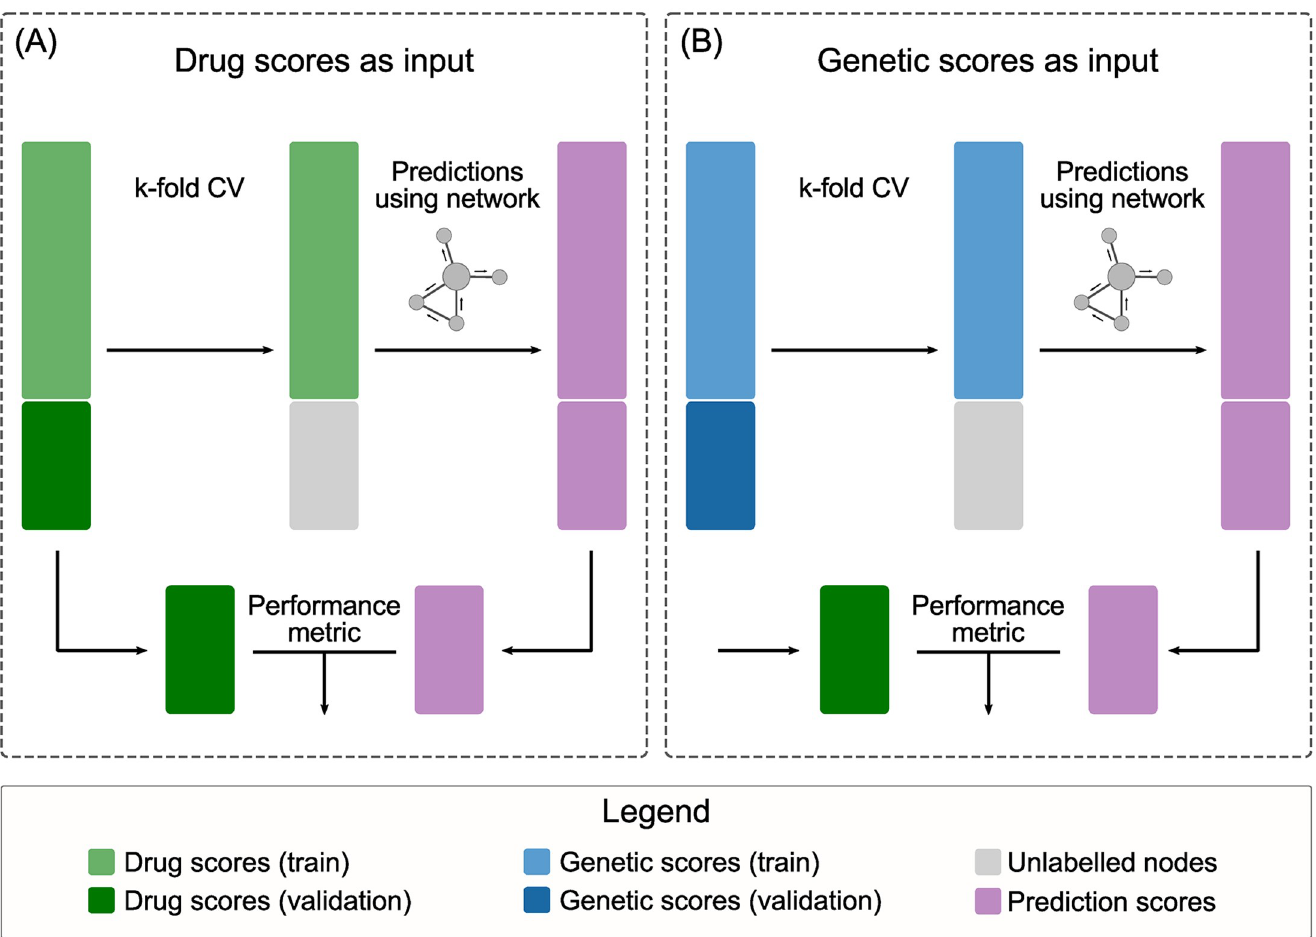
Fig 8. Input gene scores. Two input types were used to feed the prioritisation algorithms: the binary drug scores in panel (A) and the binary genetic scores in panel (B). In both cases, the validation genes were deemed unlabelled in the input to the prioritisers. Cross-validation folds were always calculated taking into account the drugs input and reused on the genetic